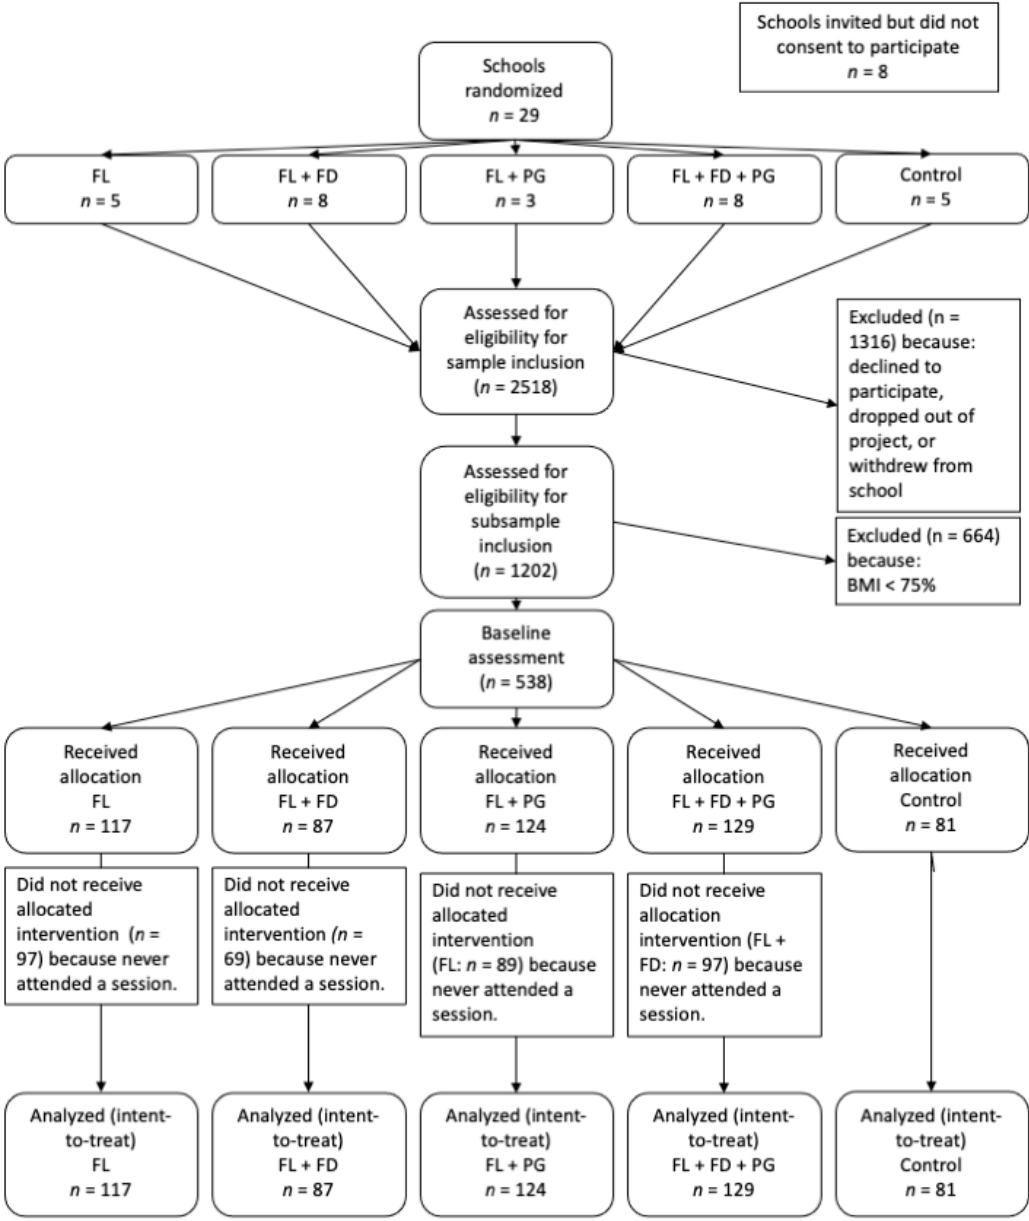
Figure 1. Study Recruitment Flow